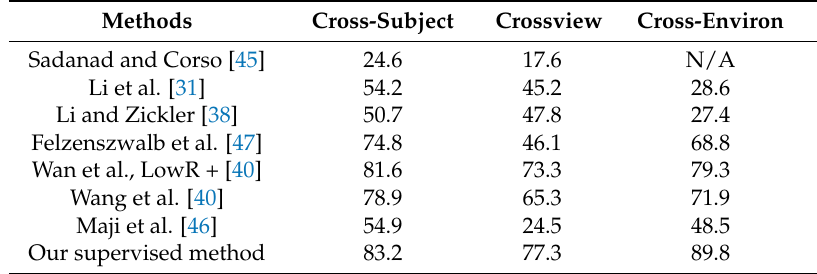
Table 5. Cross-view, cross-environment, and cross-subject action recognition outcomes on the NUMA dataset.